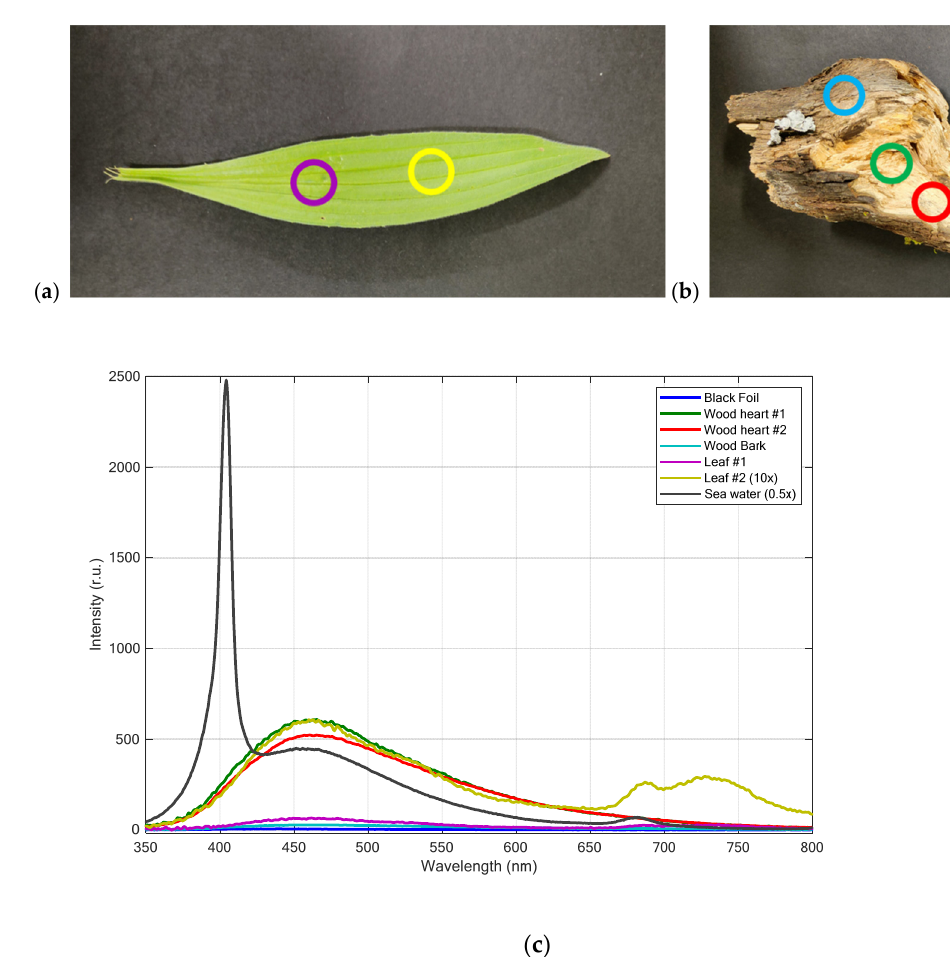
Figure 7. Fluorescence LIDAR spectra of the other materials that can be typically found as marine debris: ( a ) leaf, ( b ) wood log, and ( c ) relevant fluorescence spectra (wood heart, wood bark, leaf) together with a typical fluorescence spectrum of (mesotrophic) sea waters. For the sake of clarity, one spectrum acquired on the leaf was multiplied by a 10 factor (in order to see the chlorophyll fluorescence spectral shape) and sea water spectrum by a 0.5 factor (in order to see the Raman signal). The locations where the fluorescence measurements were acquired are marked in ( a , b ) with circles of the same color of the spectra in ( c